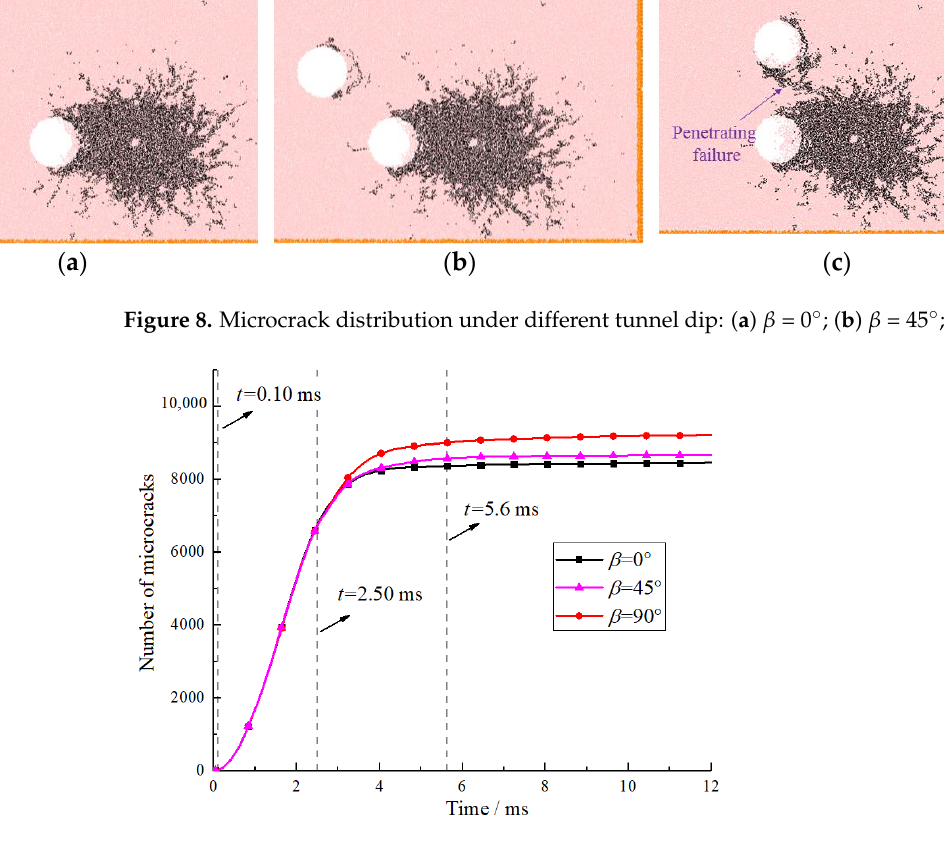
Figure 9. Development process of the microcrack.